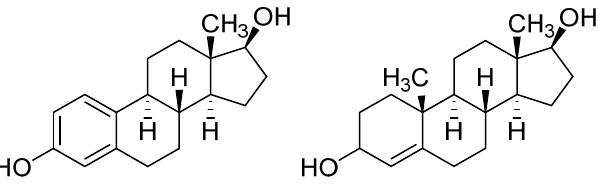
Figure 9. Structure of estradiol and testosterone.